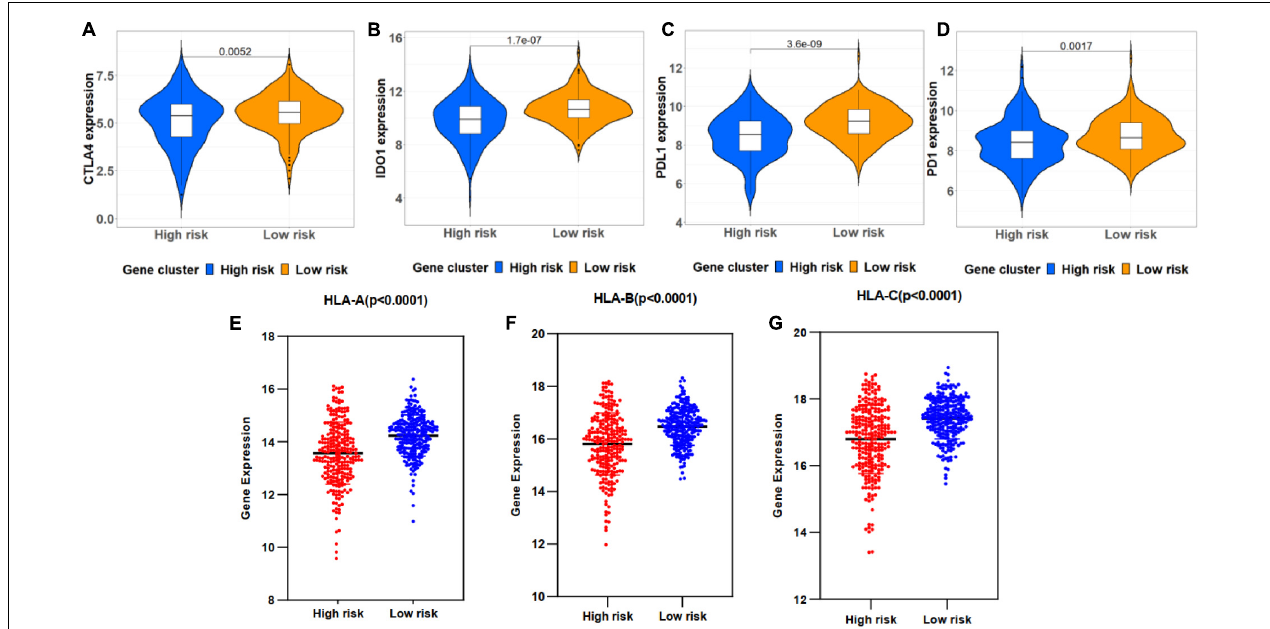
FIGURE 8 | Correlation between immune checkpoint genes and risk scores. (A–D) Immune checkpoint gene expression, including CTLA4, IDO1, PD-L1, and PD-1, in high- and low-risk groups stratified by risk signature. (E–G) HLA-A, HLA-B, and HLA-C expression in two groups.